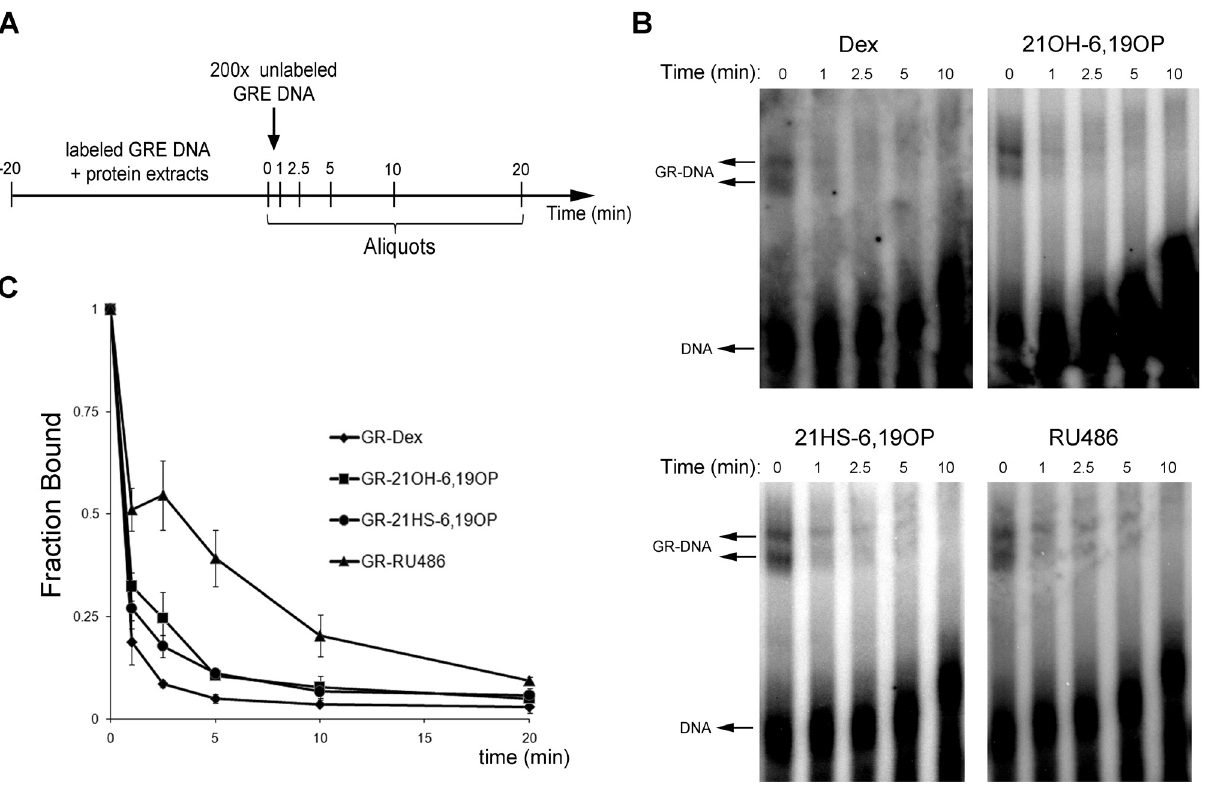
Figure 4. Ligand effect on invitro GR-DNA dissociation. EMSAs were performed using nuclear extracts from BHK21 cells treated with ethanol (Control), 10 nM Dex, 10 m M 21OH-6,19OP, 10 m M 21HS-6,19OP and 1 m M RU486 for 30 min. Protein extracts incubated with a 32 P-radiolabeled oligonucleotide containing a GRE sequence were subject to the experimental design shown in A . B . Aliquots for each treatment were loaded into a running gel and images were analyzed. C . Dissociation curves (mean 6 S.E.) from three independent experiments show the fraction bound (relative to time zero) expressed as the ratio between GR-DNA complexes and free DNA probe. The arrows indicate the free DNA and the GR-DNA complexes.